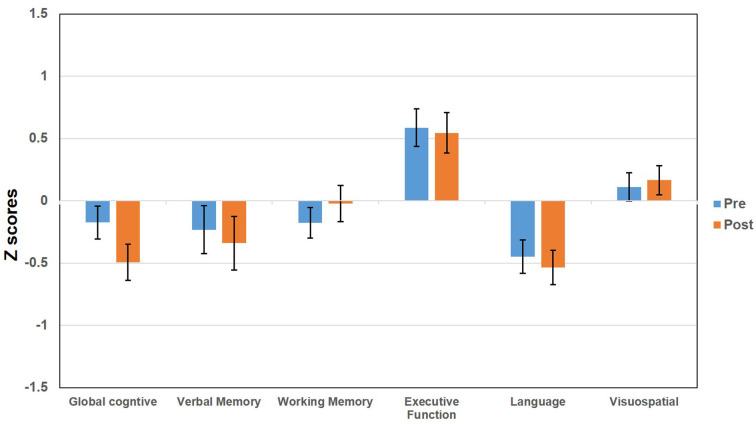
Bar graphs represent the pre and post deep brain stimulation (DBS) score (z scores) for essential tremor (ET) patients tested across multiple domains including global cognitive function, verbal memory, working memory, executive functioning, language, and visuospatial functioning. The error bars represent the standard error of the mean.